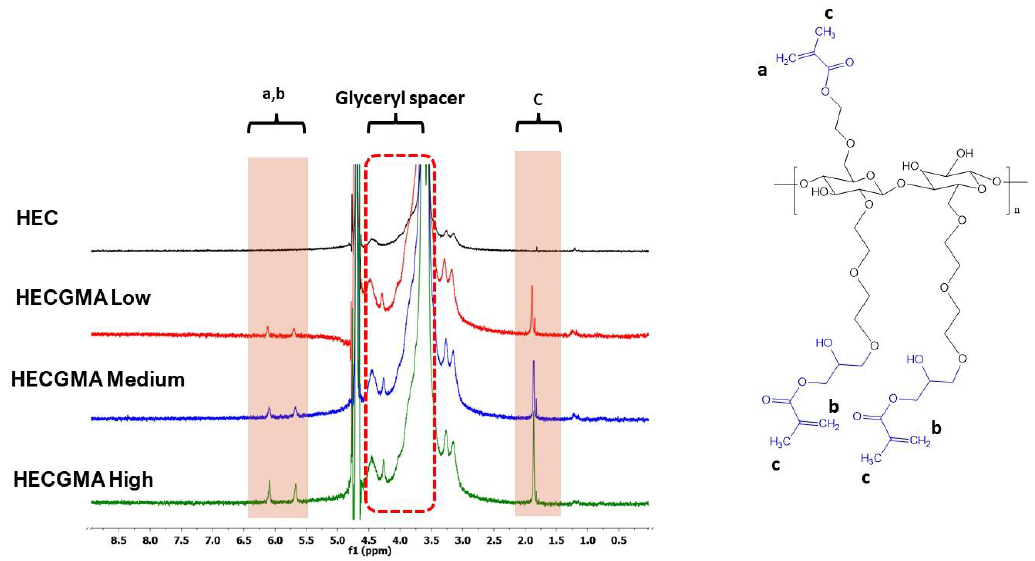
Figure 2. Structure and 1 H NMR spectra of unmodified HEC and HECGMA prepared at various molar ratios of HEC to GMA.